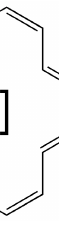
Figure 2. One of the D 3h Kekule structures of [18] ‐ annulene.